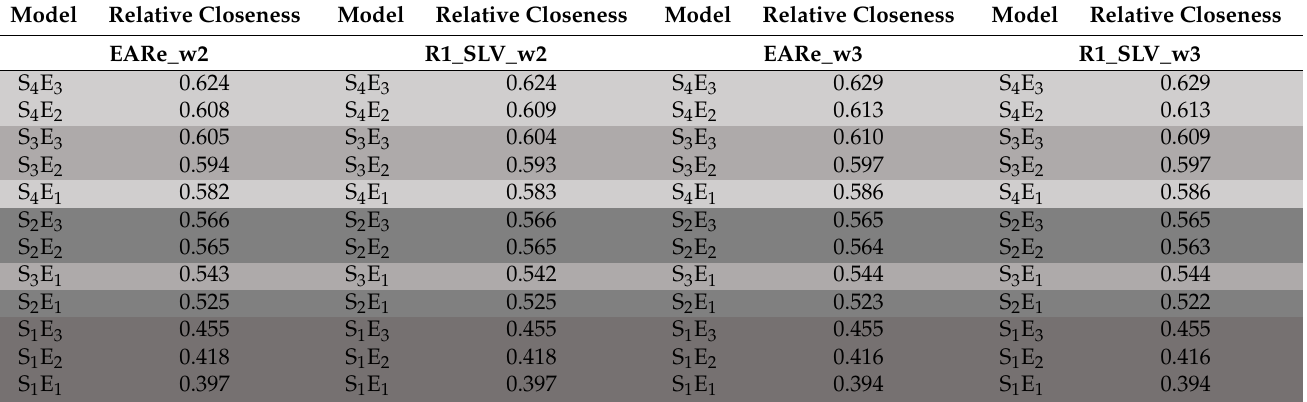
Table 8. Rank using weight vectors w2 and